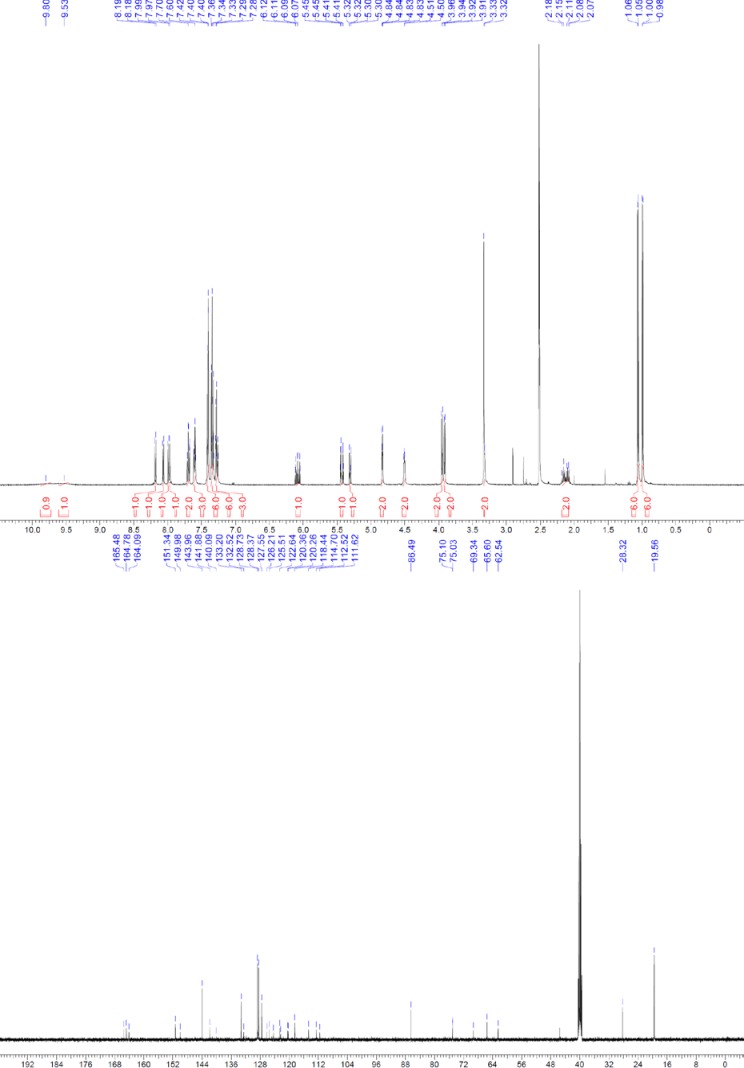
1H and 13C NMR of compound 11.